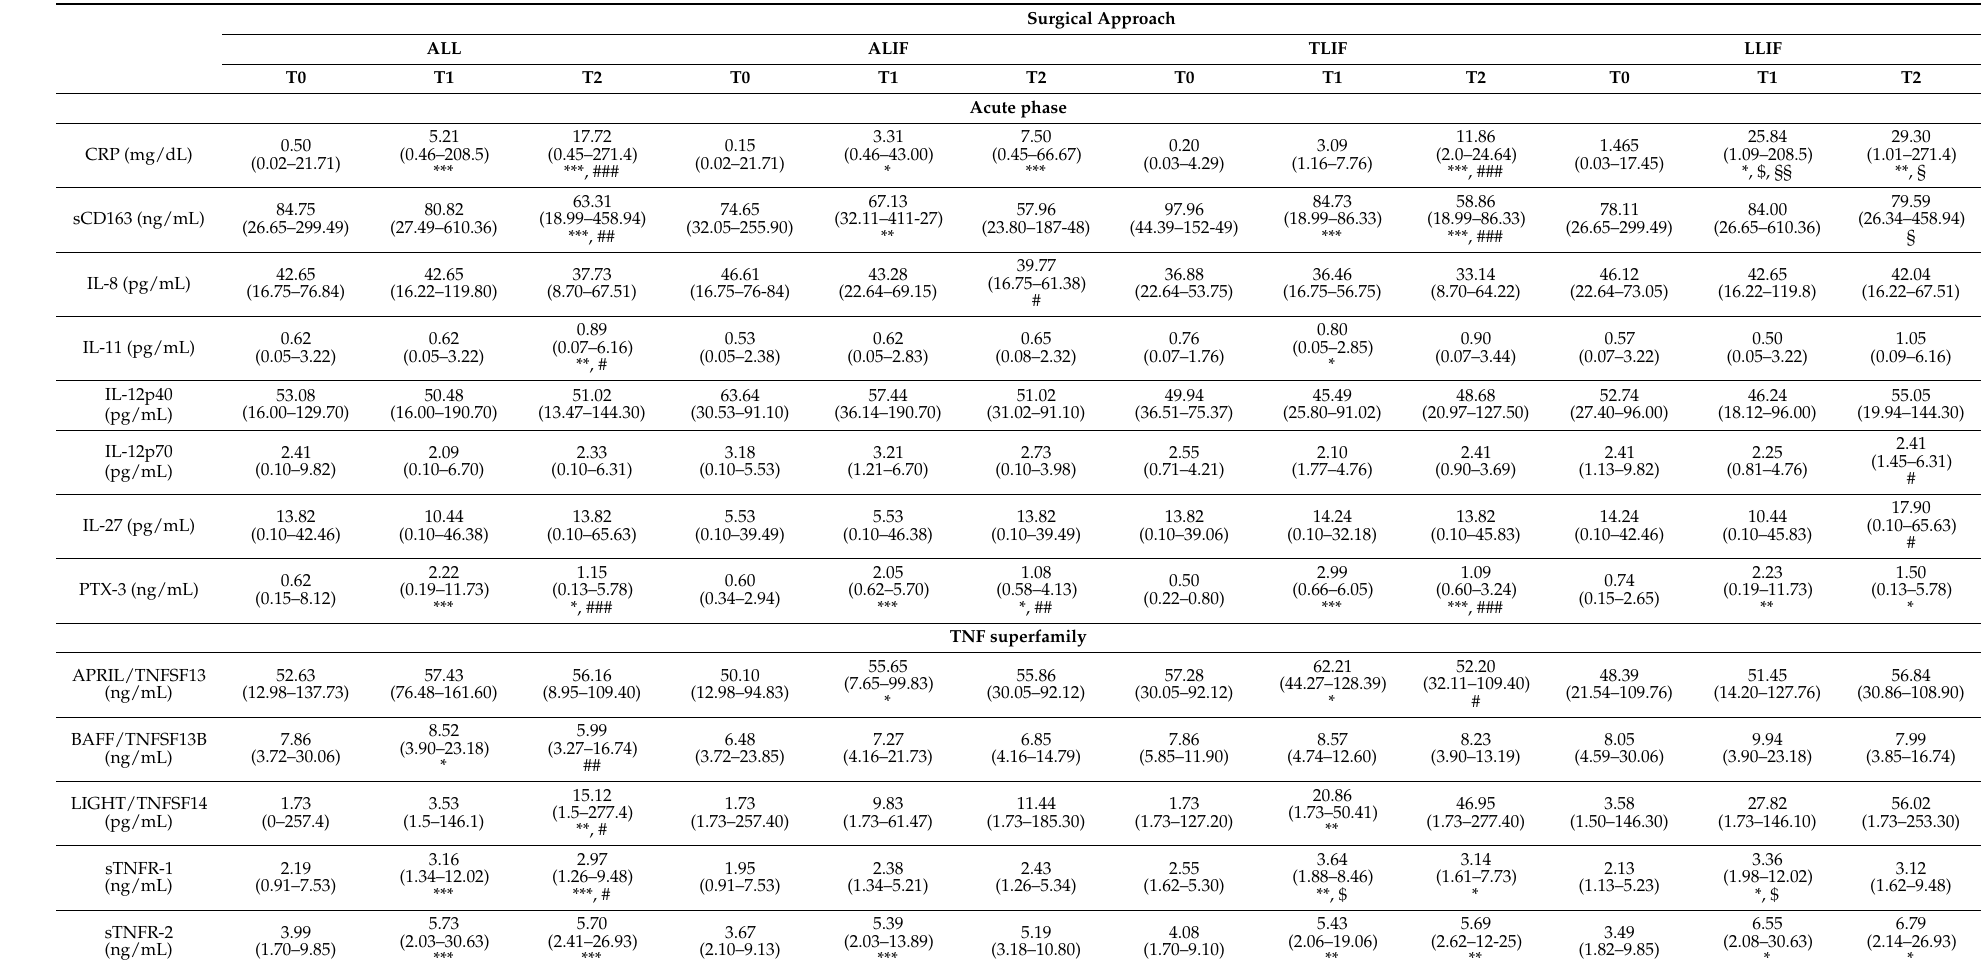
Table 3. Inflammatory markers over the peri-surgical